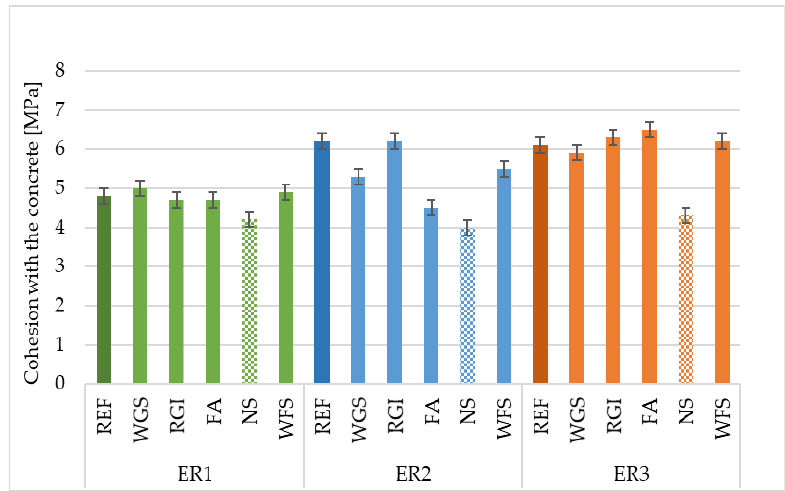
Figure 7. Cohesion of epoxy composites with concrete depending on the type of filler and epoxy binder used.